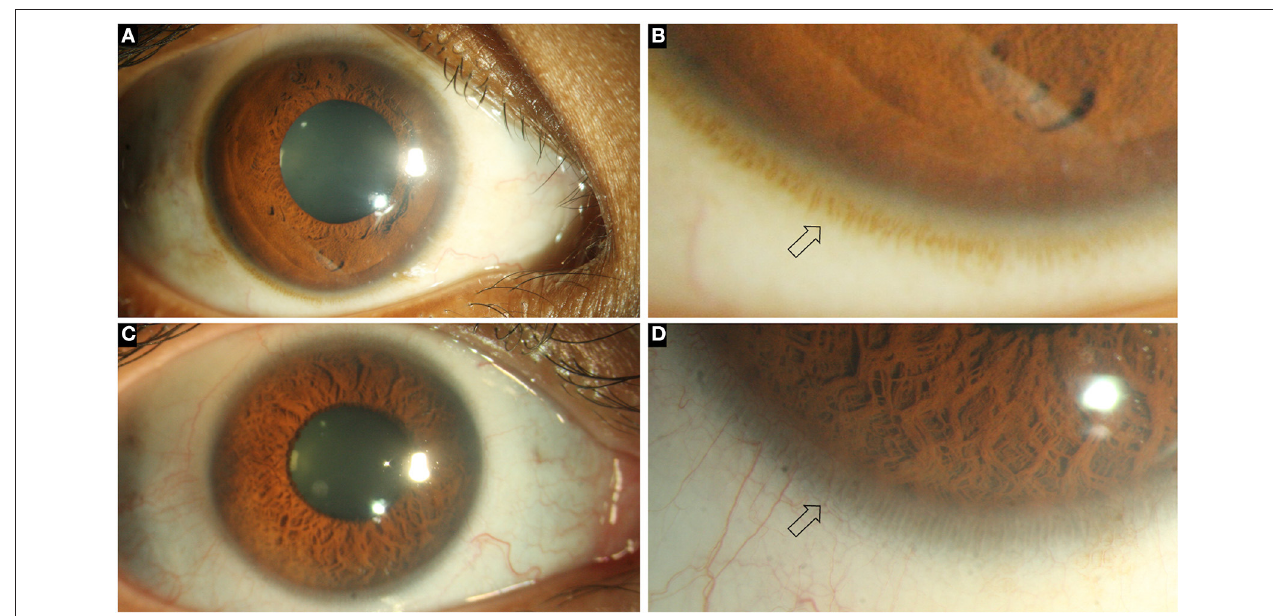
FIGURE 1 | Collage of images depicting the normal ocular surface and limbus (arrows) in pigmented (A, B) and hypopigmented (C, D) eyes.